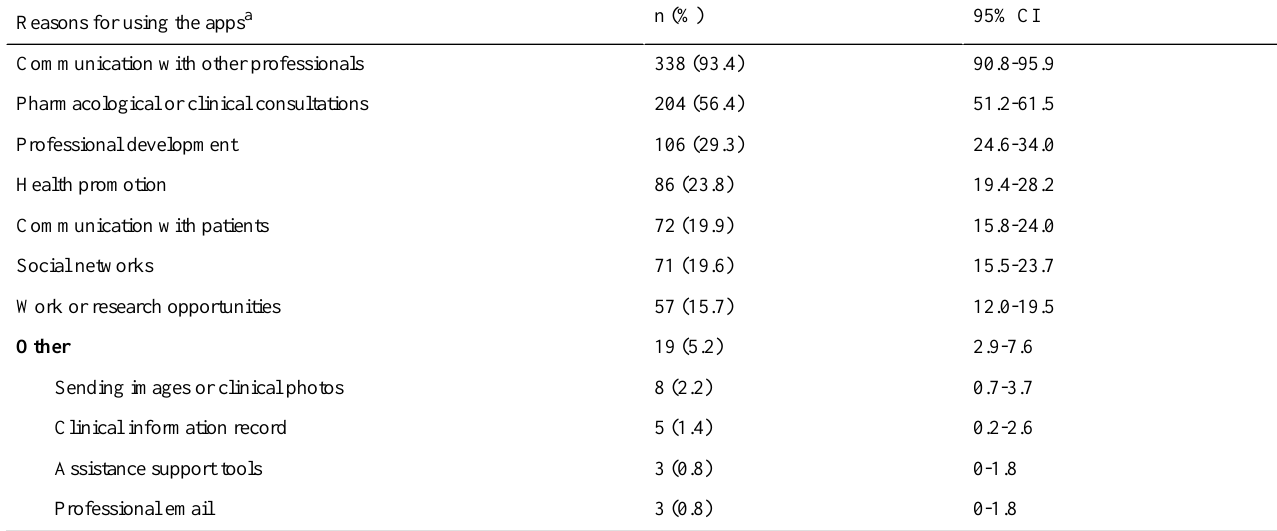
Table 5. Reasons given by the professionals (n=362) for using social networking site